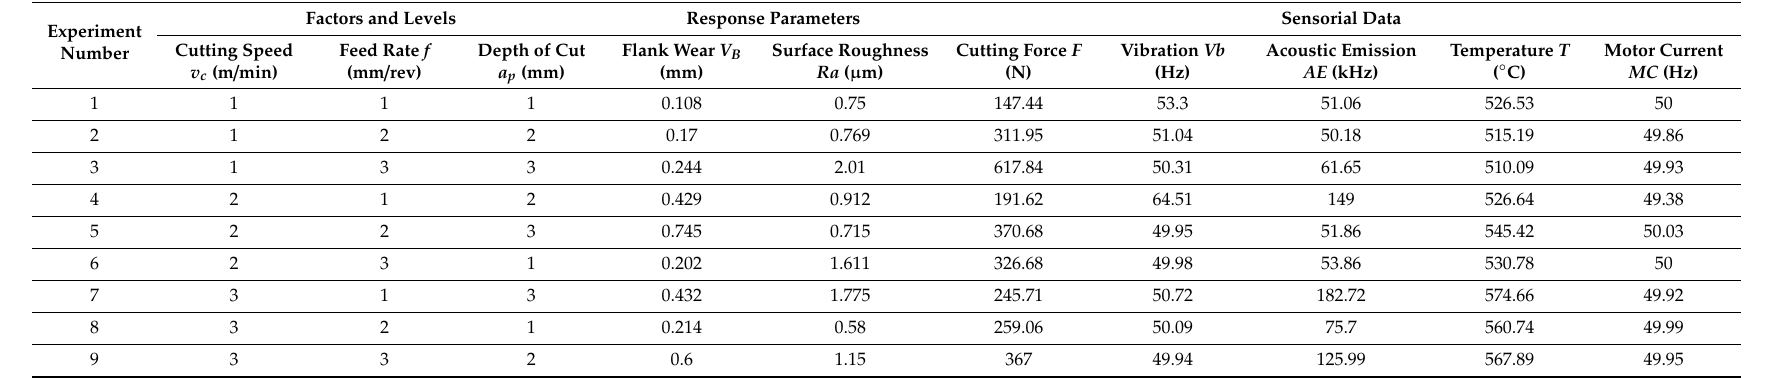
Table 4. The experimental design and